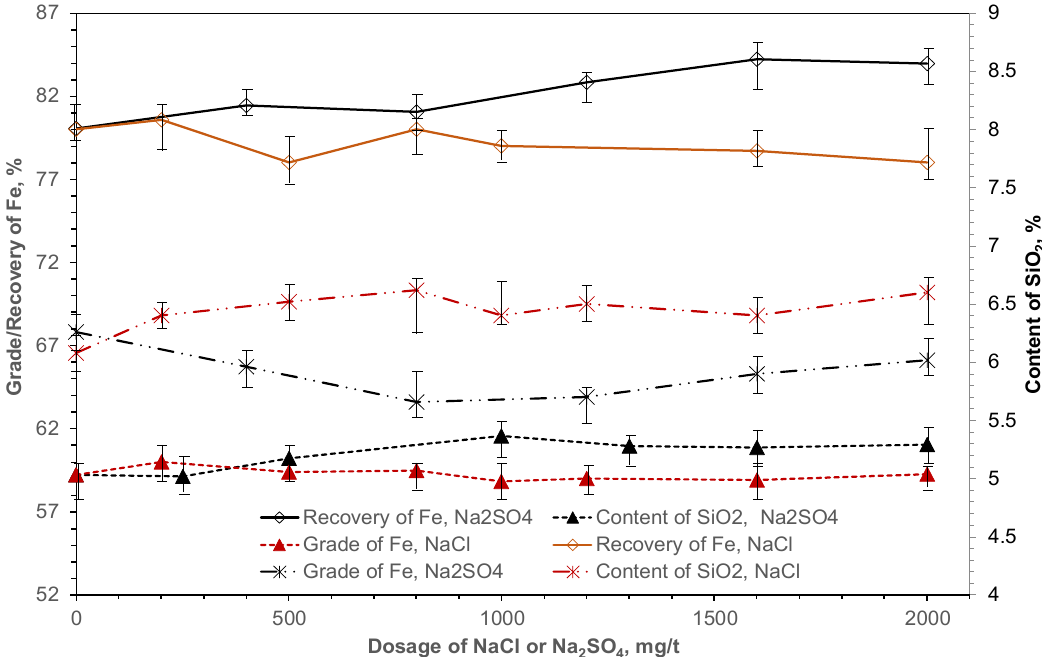
Figure 7. The effect on the recovery/grade of Fe and content of SiO 2 in concentrate as a function of dosage of Cl − or SO 42 − ions in the tap water.